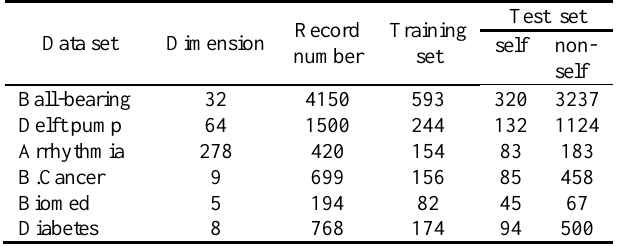
Table 2. The data prosperities of the UCI data sets.